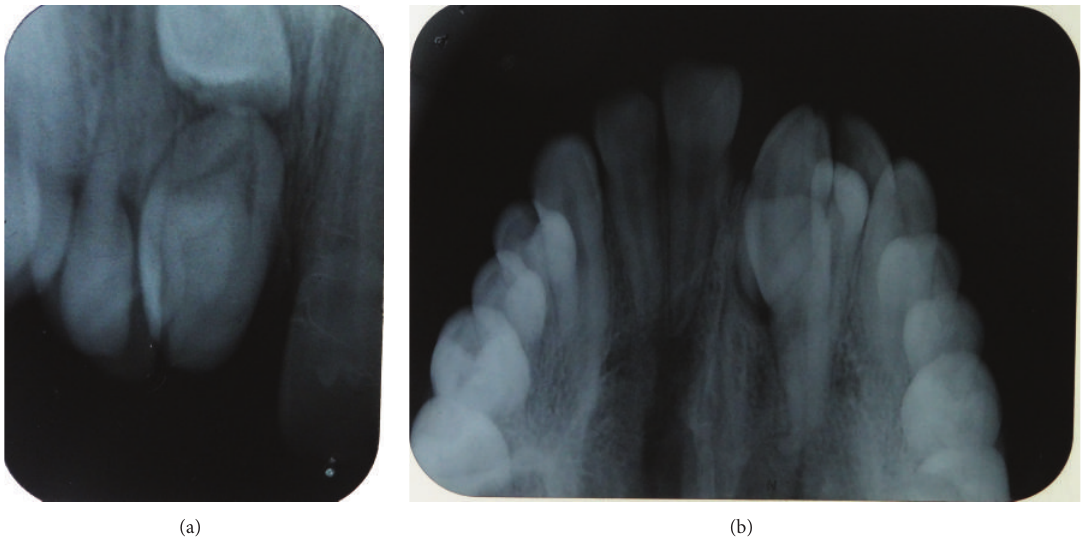
Figure 3: (a) Intraoral periapical radiograph and (b) anterior maxillary occlusal radiograph showing an erupted dilated odontoma with impacted central incisor.